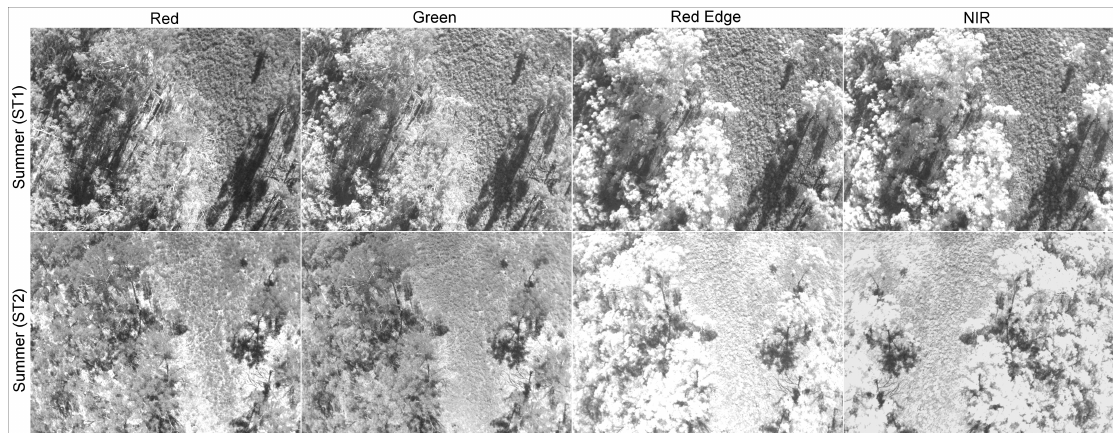
Figure 4. Single spectral band images (columns left to right) for red, green, red edge, and near infrared (NIR) cameras captured in summer during morning (top row) and midday (bottom row) flights.